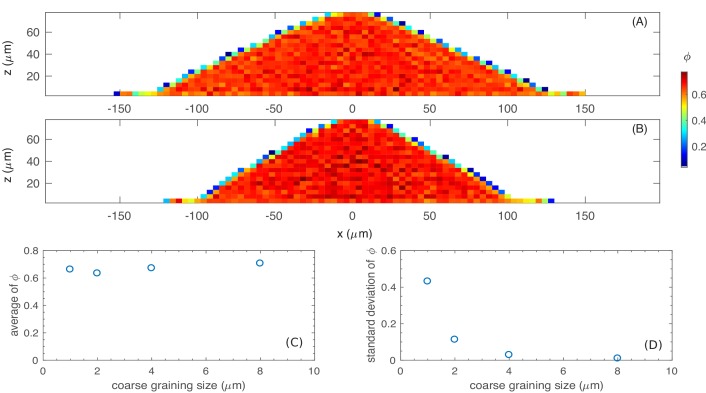
The spatially varying cell density ρ (per unit volume of colony) is related to the spatially varying cell volume fraction ϕ by ρ=ϕρcell, where the volume fraction ϕ is defined as the volume of all cells in a unit volume of the colony and ρcell is the constant mass density of a typical mature cell; cf. Appendix 1.2 on nutrient update.(A) and (B): The volume fraction ϕ in the xz cross section of the colony, calculated with the mean m and standard deviation σ, with (A) λS=1.0h-1, m=0.678, and σ=0.030; and (B) λS=0.5h-1, m=0.680, and σ=0.034. (C) and (D): The effect of coarse-graining size to the volume fraction ϕ. The average of ϕ (C) and the standard deviation of ϕ (D) in the coarse-graining with different sizes.